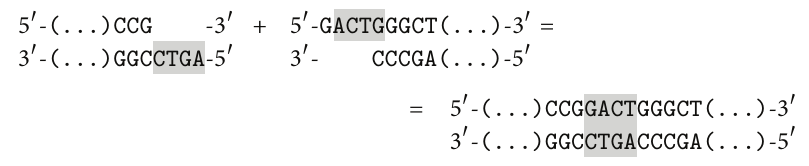
Figure 1: Annealing and